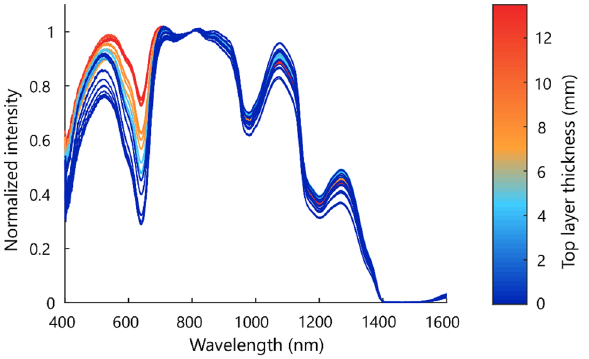
Figure 5. Normalized diffuse reflectance spectra of different locations on the artificial phantom, using a fiber distance of 2 mm. The color represents the thickness of the top layer at the measured location. The bottom layer contained patent blue, with a peak absorption at 635–640